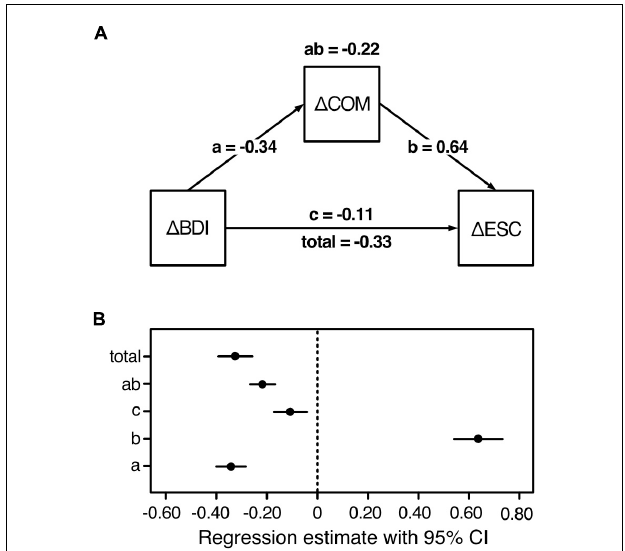
FIGURE 3 | Results and model of the mediation analysis of the first sample ( n 1 = 459). BDI, depressive symptoms; COM, cognitive motivation; ESC, effortful self-control; (cid:49) , latent change score (i.e., the change from t 1 to t 2 ). (A) Increasing cognitive motivation partially mediates the association between decreasing depressive symptoms and increasing self-regulation. The following unstandardized effects are displayed: total (direct effect without mediation) = ab (indirect mediating effect) + c (direct effect with mediator). (B) 95% confidence intervals of the unstandardized regression estimates, based on 1,000 bootstrap